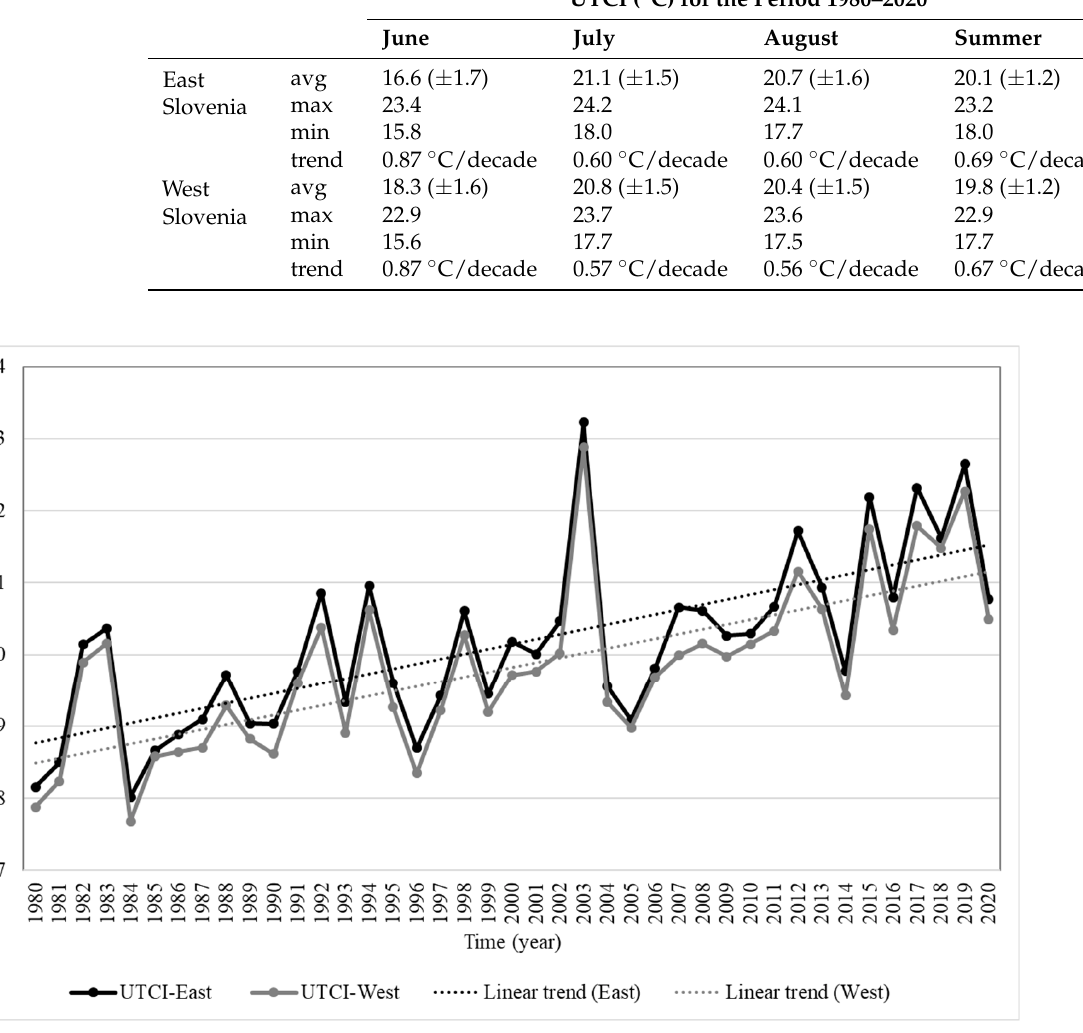
Figure 2. Average summer Universal Thermal Climate Index (UTCI) (June to August) in the period 1980–2020 for eastern and western Slovenia.